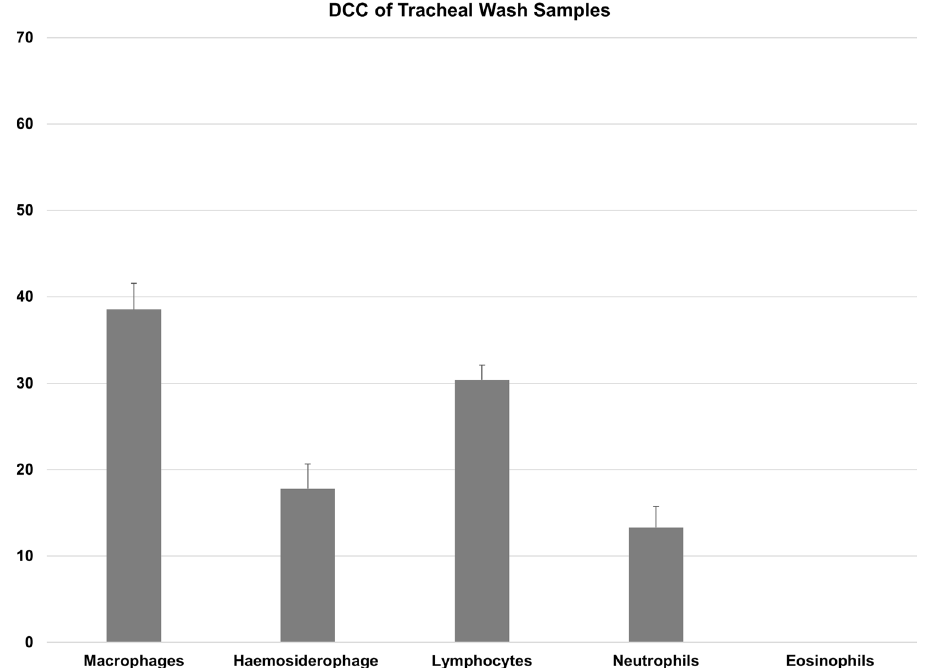
Figure 3. Differential cell count (mean + SEM %) of equine tracheal wash samples (n = 39). Differential leucocyte count (minimum of 200 cells) was performed and expressed as a percentage of total non-squamous and non-epithelial nucleated cells.